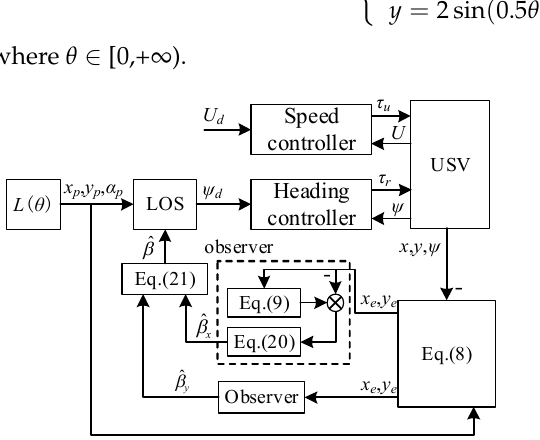
Figure 3. Block diagram of the IMCLOS-based path following system.